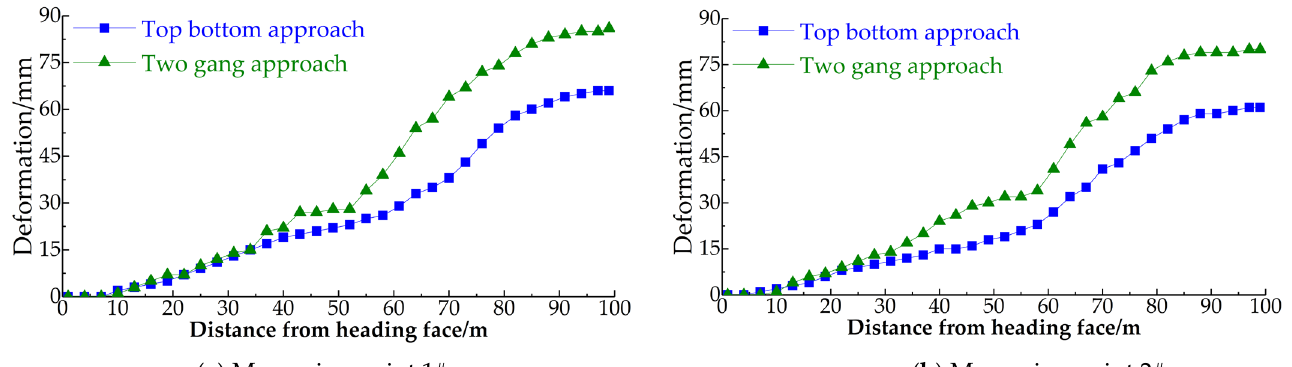
Figure 18. Line chart of surrounding-rock deformation of the roadway.